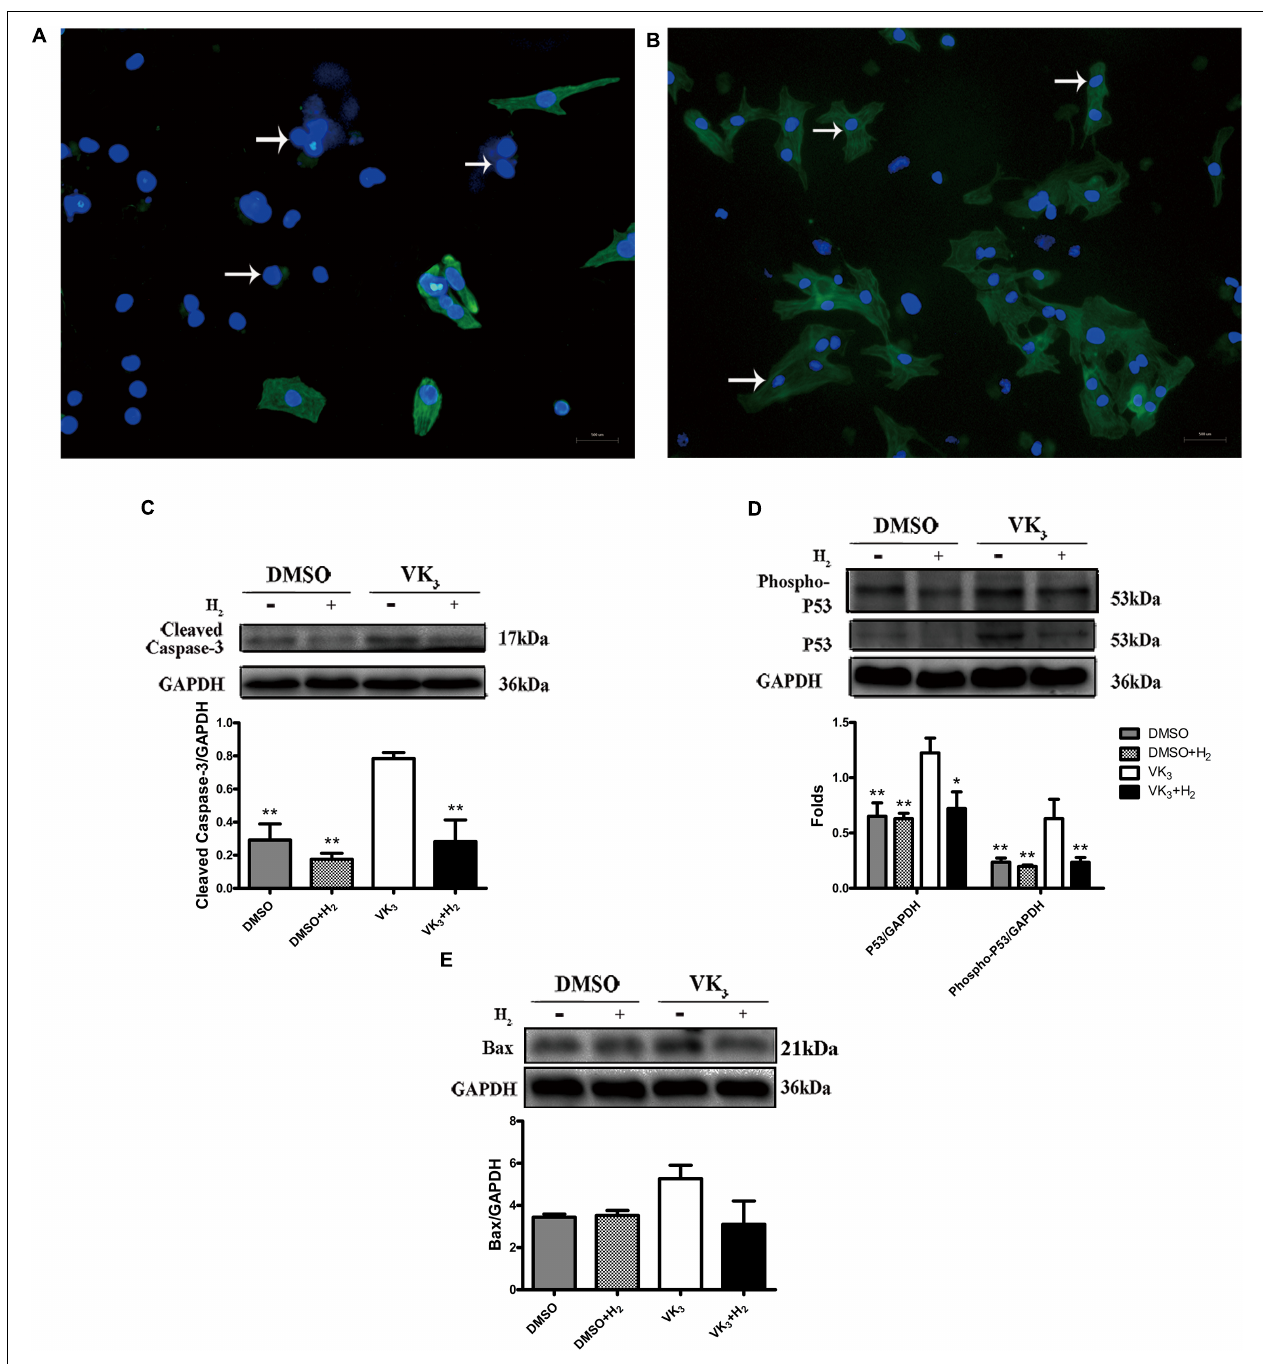
FIGURE 7 | Analysis of effects of H 2 on primary cardiomyocytes with oxidative stress. (A,B) Identification of primary cardiomyocytes. Representative photomicrographs of fluorescence are shown. Myofilaments were marked with the green fluorescence, representing the expression of TnT ( B , arrows) which was negative in fibroblasts ( A , arrows) (magnification of 100 × ). Scale bar = 500 µ m. (C–E) Confirmation by Western blot analyses for the expression of cardiac cleaved caspase-3, phospho-p53, p53, and Bax in primary cardiomyocytes. Representative photographs are shown. GAPDH was used as a loading control. Expressions of cleaved-caspase-3, phospho-p53, p53 and Bax were, respectively, quantified as folds of GAPDH ( n = 3–5). The columns indicate the mean, and the bars indicate the SD (MDA and cell viability) or SE (Western blotting). ∗ p < 0.05 vs. VK 3 ; ∗∗ p < 0.01 vs. VK 3 ; && p < 0.01 vs. VK 3 +H 2 .